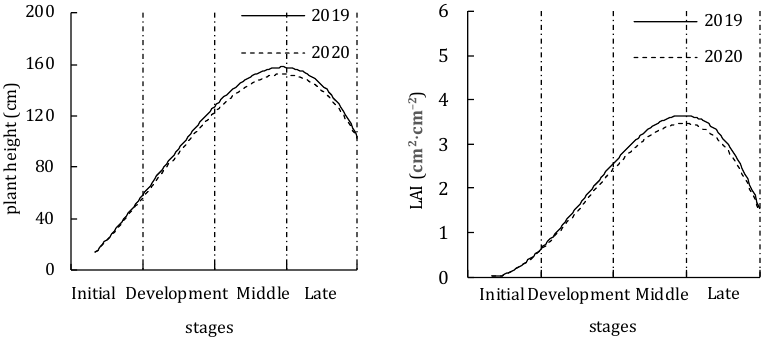
Figure 2. Variations of tomato plant height and LAI in 2019 and 2020.